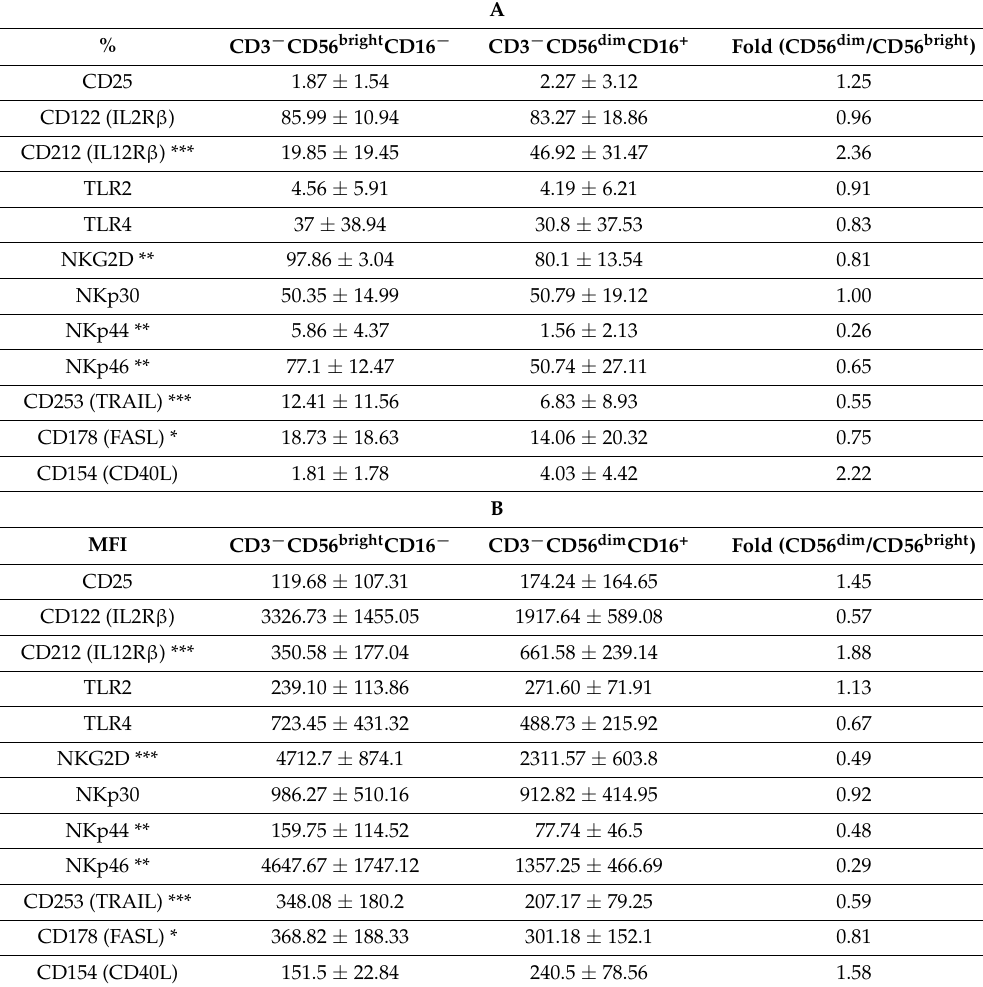
Table 1. Percentages and mean fluorescence indices (MFI) of cytokine or cytotoxicity receptor- and death ligand-expressing CD56 bright or CD56 dim HI NK cells. Percentages (upper panel A ) and MFI (lower panel B ). The Wilcoxon matched-pairs signed-ranks test was performed using GraphPad InStat Ver 3. N = 6 for NKG2D and N = 12 for others. * p < 0.05, ** p < 0.01, *** p <